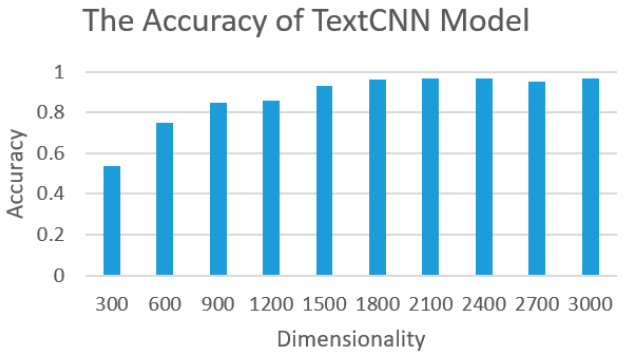
Figure 8. The accuracy of the TextCNN Model.